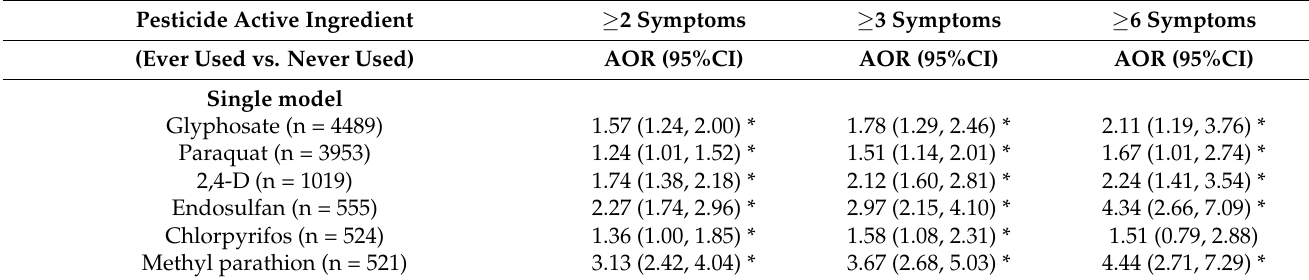
Table 5. Association of individual pesticide exposure with mental disorder in Thai farmers (n = 6974). ≥ 2 Symptoms ≥ 3 Symptoms ≥ 6